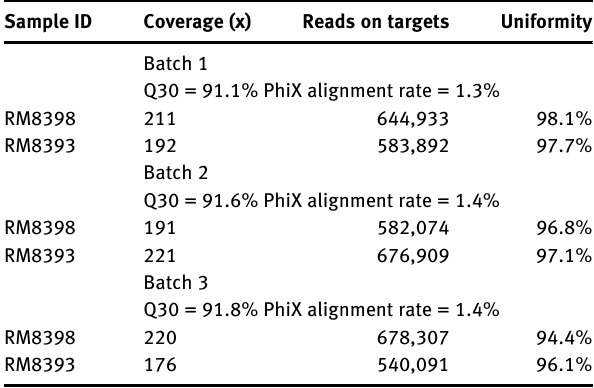
Table  : Summary of quality control (QC) metrics of the three batches of  -plex